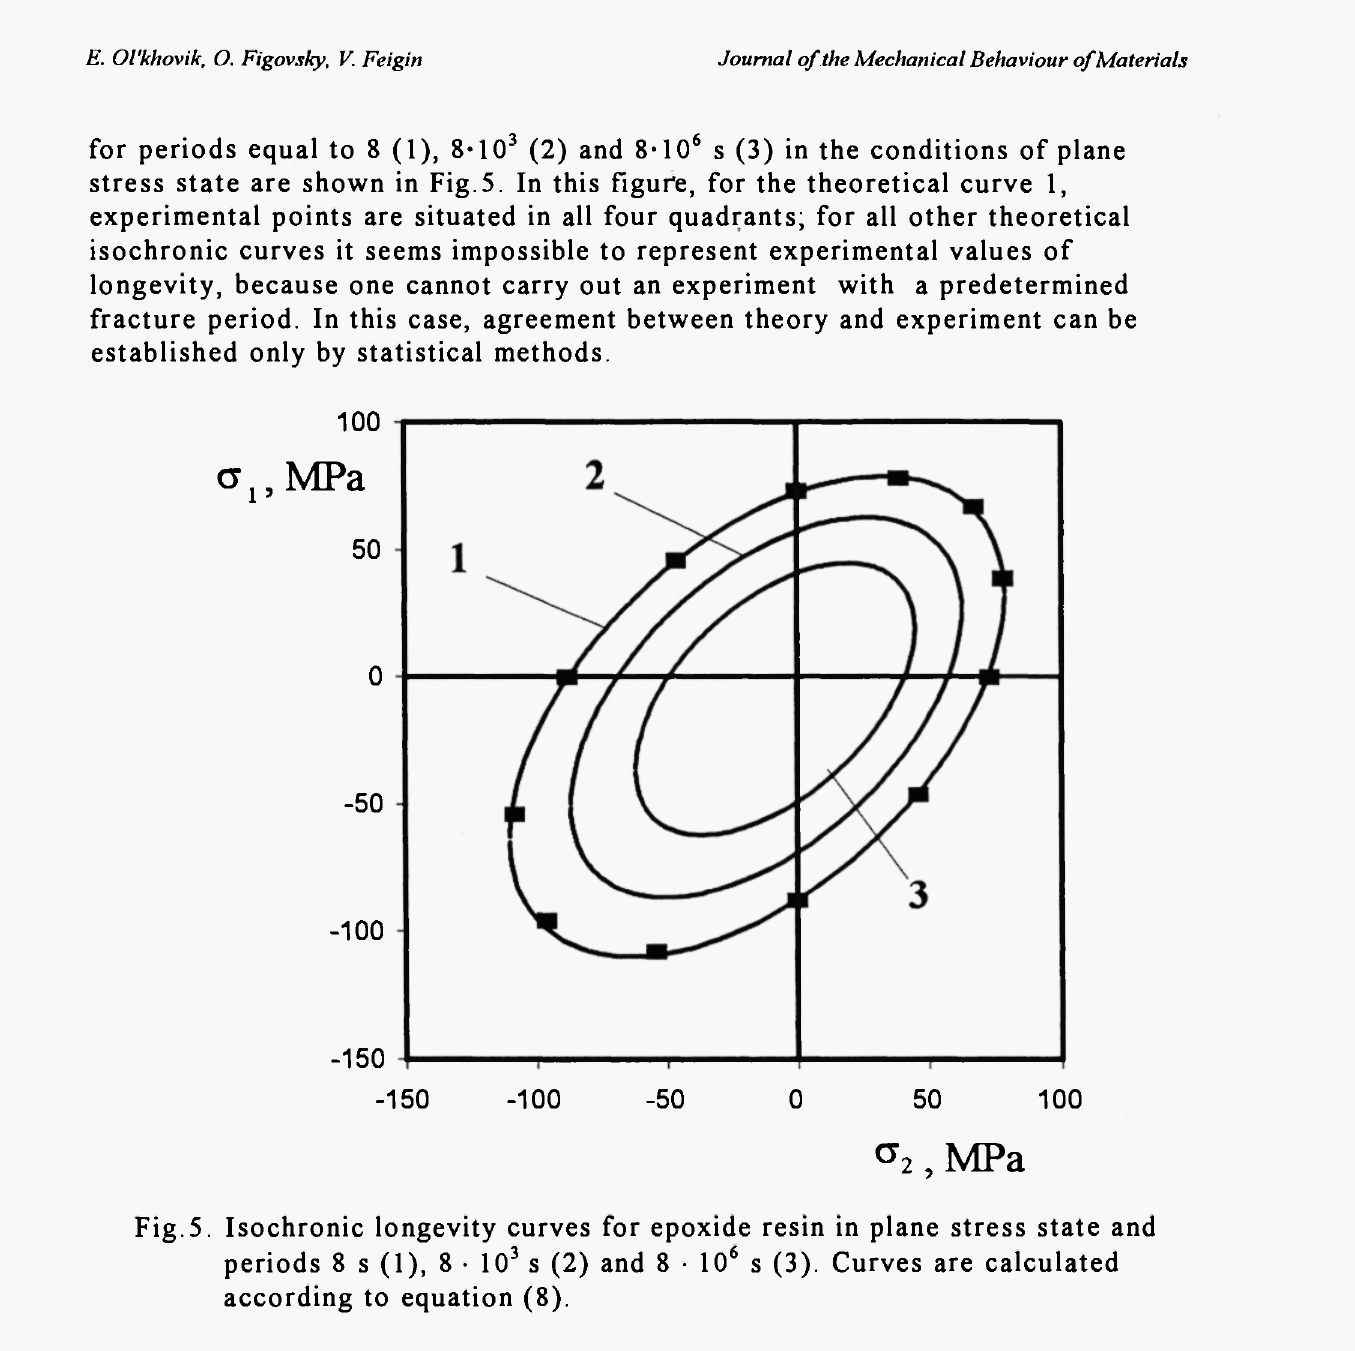
Fig.5. Isochronic longevity curves for epoxide resin in plane stress state and periods 8 s (1), 8 · 10 3 s (2) and 8 · 10 6 s (3). Curves are calculated according to equation